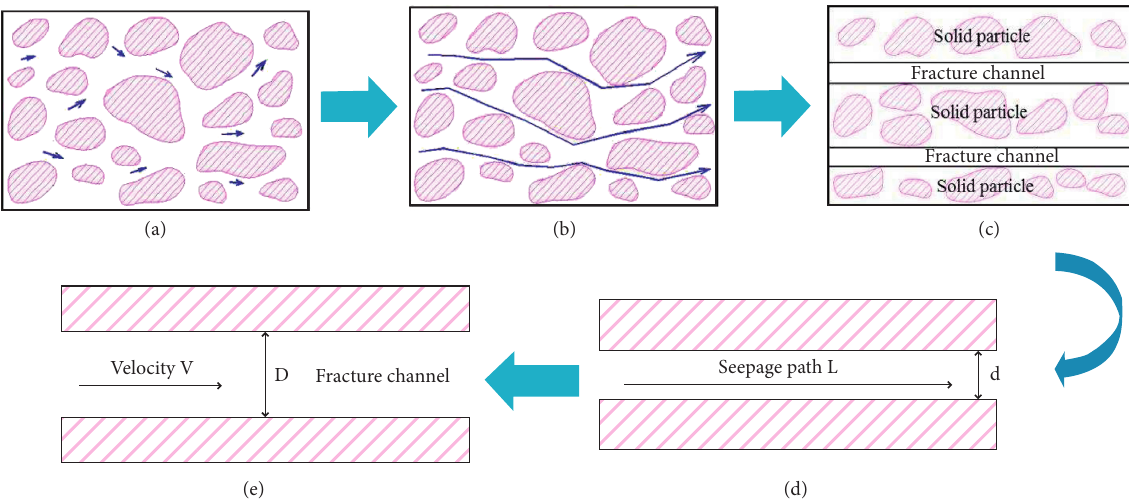
Figure 8: Schematic diagram of crack channel expansion in rock. (a) Water enters rock pore state. (b) Formation of seepage channel. (c) Postgeneralization model. (d) Equivalent fracture channel. (e) Fracture channel widening.